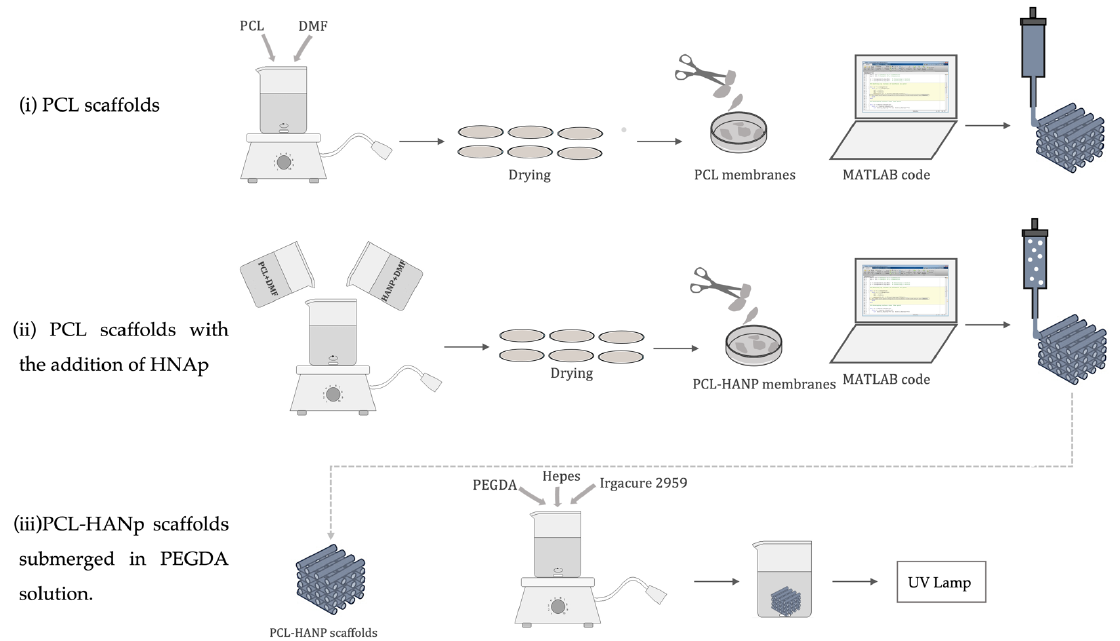
Figure 1. Schematic representation of the process for the manufacture of scaffolds.